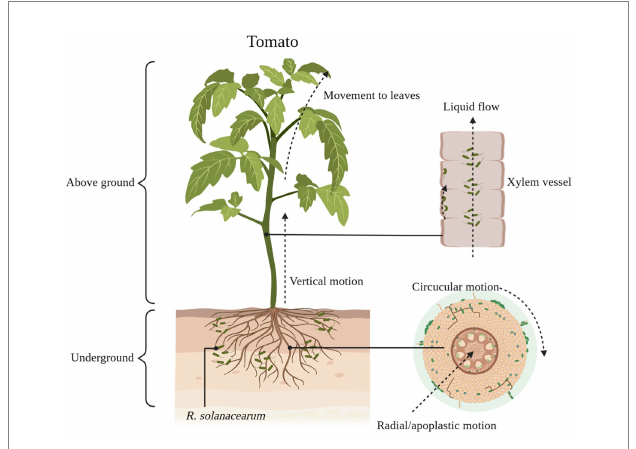
FIGURE 1 The process of Ralstonia solanacearum infesting tomatoes. R . solanacearum enter the xylem of tomatoes through the cell spaces of the roots. It gradually reaches the xylem through radial and circumferential movements before entering the xylem (lateral movement) and then moves vertically upward through the xylem vessel to the above-ground part of the tomato (longitudinal movement). Some of the R . solanacearum attach themselves to the xylem duct walls and use this area as an ecological niche for colonization, while others are suspended in the duct’s fluid stream up to the leaf area. Schematic diagram is drawn through BioRender